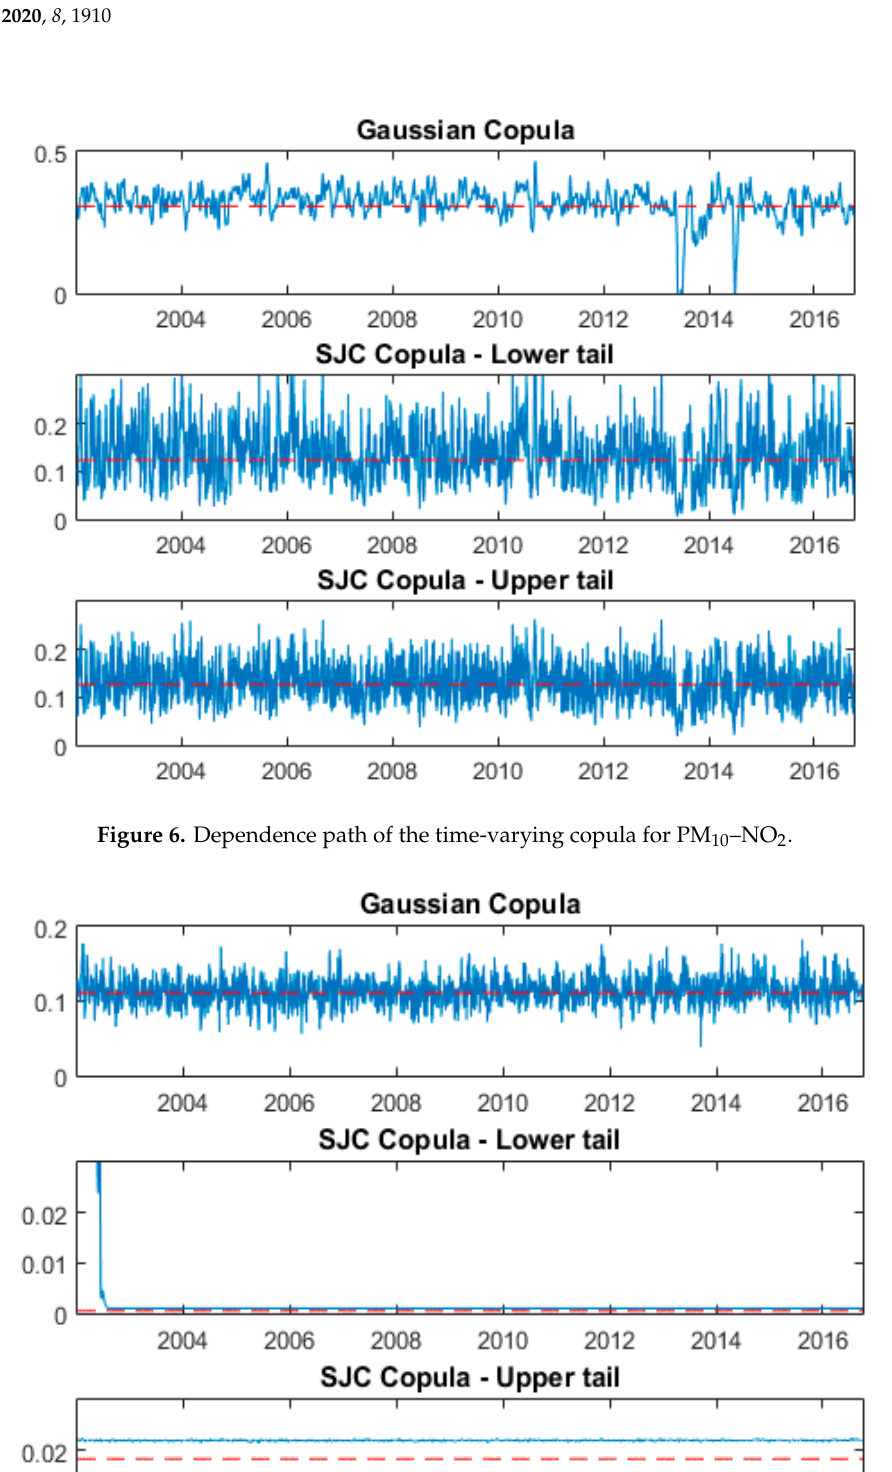
Figure 5. Dependence path of the time-varying copula for PM 10 —CO.